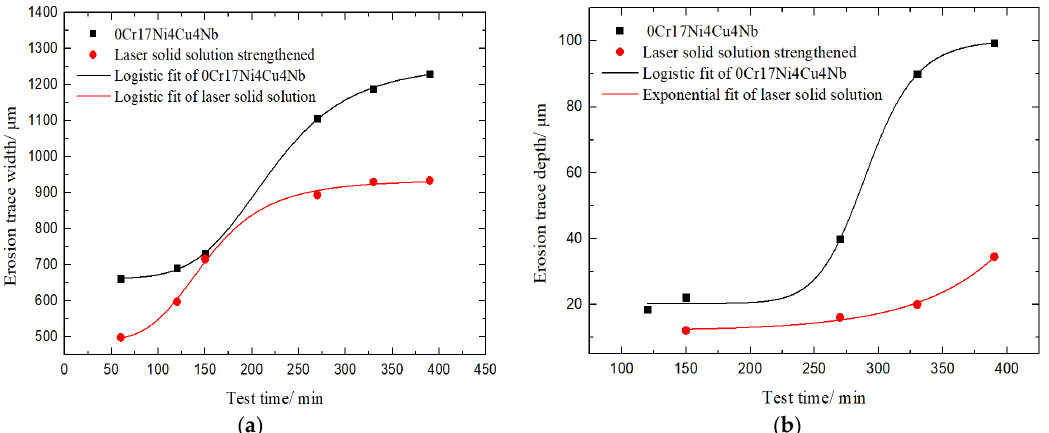
Figure 7. Curves of impact width and depth at different time of substrate and solid solution reinforced samples. ( a ). The erosion trace width along test time; ( b ) The erosion trace depth along test time.